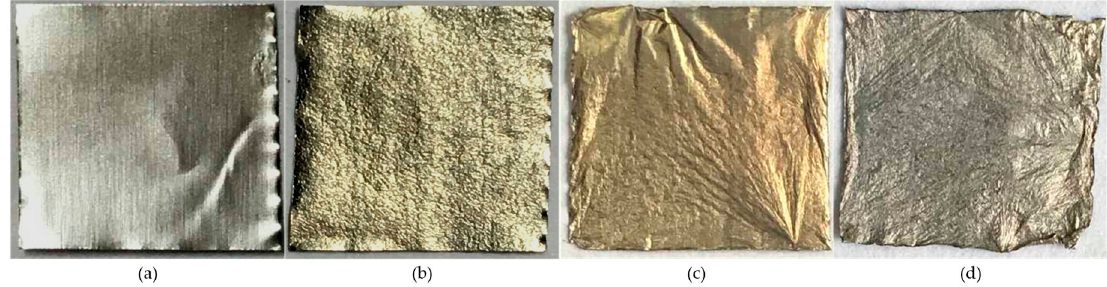
Figure 2. The photos of the aluminum foil substrates after the CNT formation process at ( a ): 600, ( b ): 700, ( c ): 800, and ( d ): 900 °C.